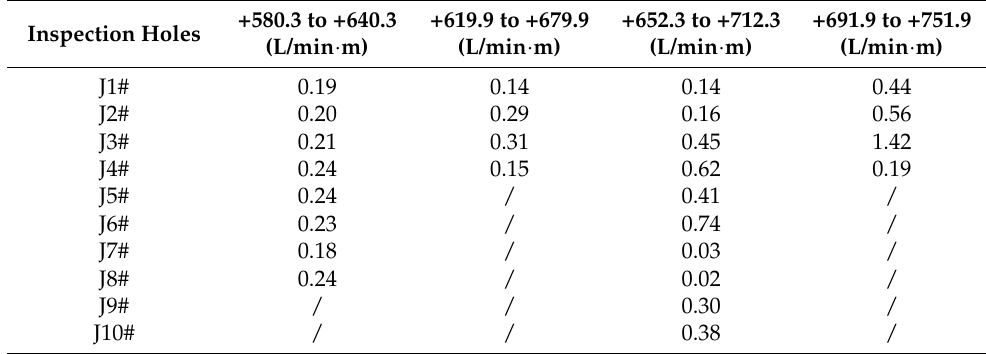
Table 17. Water output from excavated sections of Gaoligong Mountain